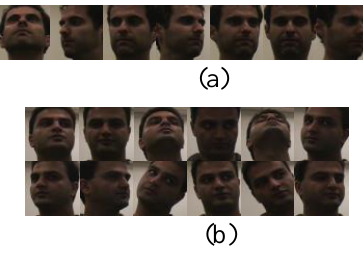
Figure 6. Center of clusters for two video sequences of Honda/UCSD database.